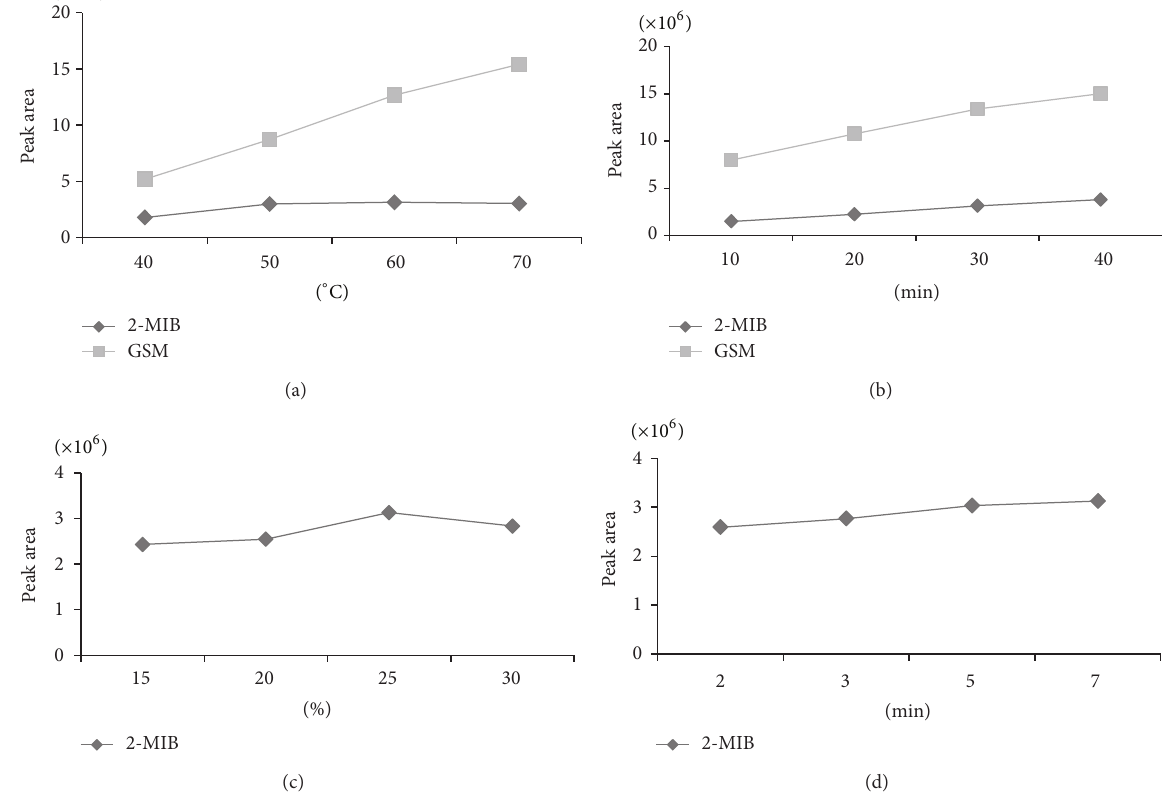
Figure 2: The effects of extraction temperature, extraction time, ionic strength, and desorption time on responses. (a) extraction